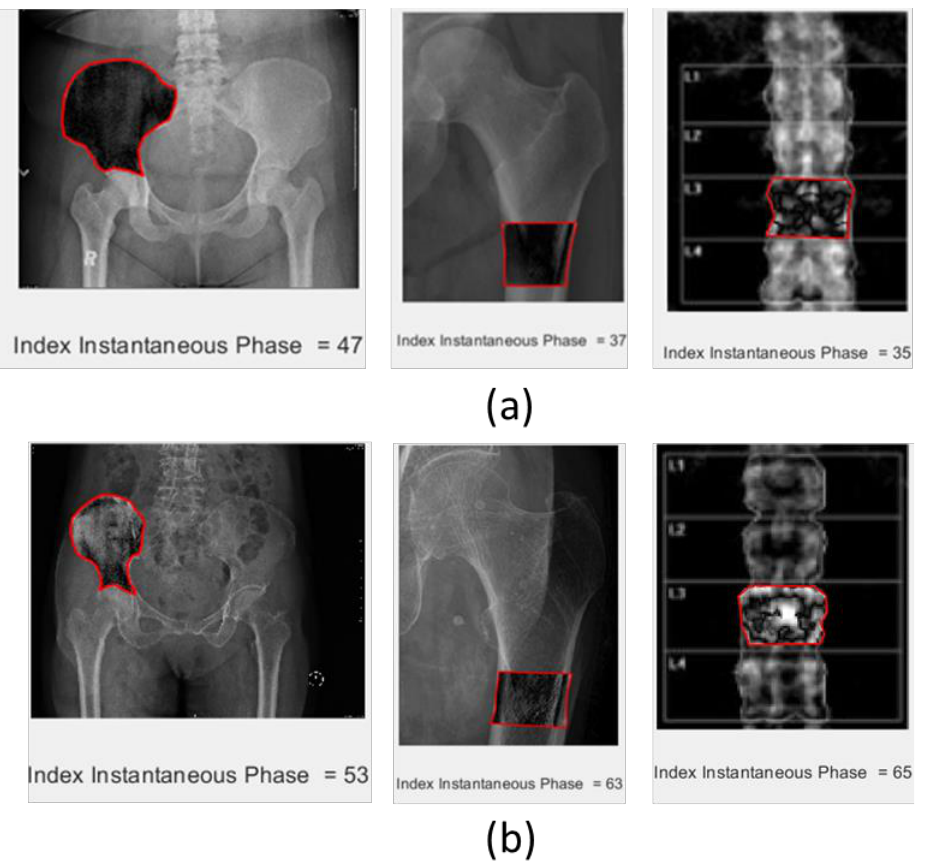
Figure 6. Phase index of different image data of pelvic (left), hip (middle), and lumbar spine (right); ( a ) normal bone and ( b ) osteoporotic bone, red box indicate a selected ROI.